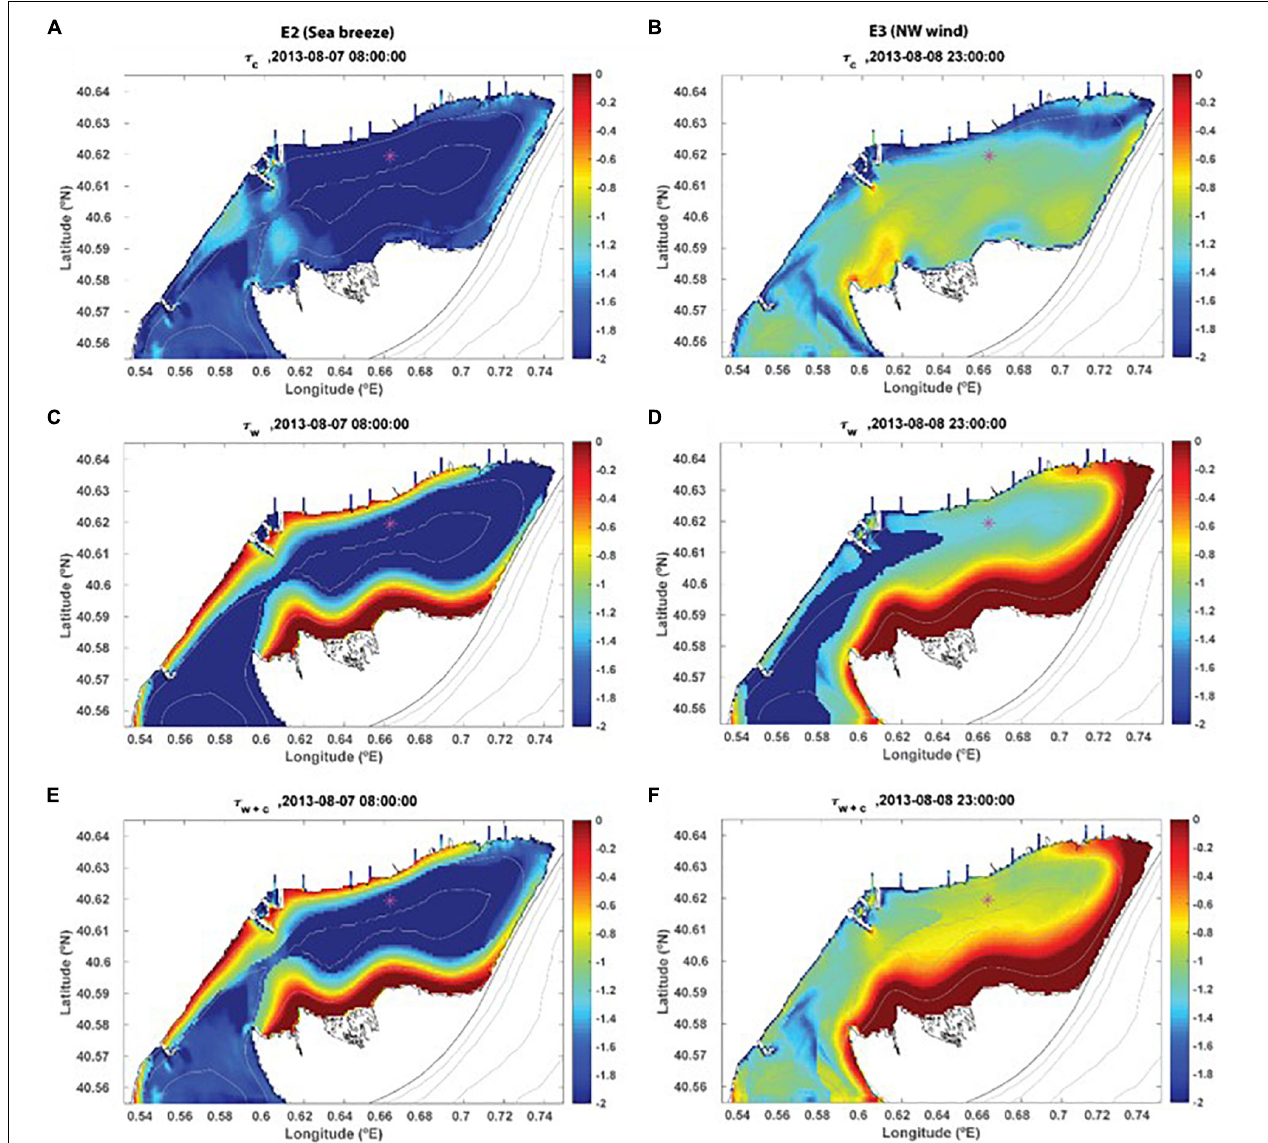
FIGURE 7 | Distribution of bottom shear stresses under sea breeze (from E , left column, corresponding to boxes A,C,E ) and land wind (from NW, right column, corresponding to boxes B,D,F ). The presented bottom shear stress spatial distributions correspond to 3D circulation (boxes A,B ), incoming wave fields (boxes C,D ) and the nonlinear combination of wave-circulation fields (boxes E,F ). All plots represent the Alfacs Bay in the southern Ebro delta within the Catalan coast pilot case, and for clarity all plots are drawn in logarithmic scale (in 10